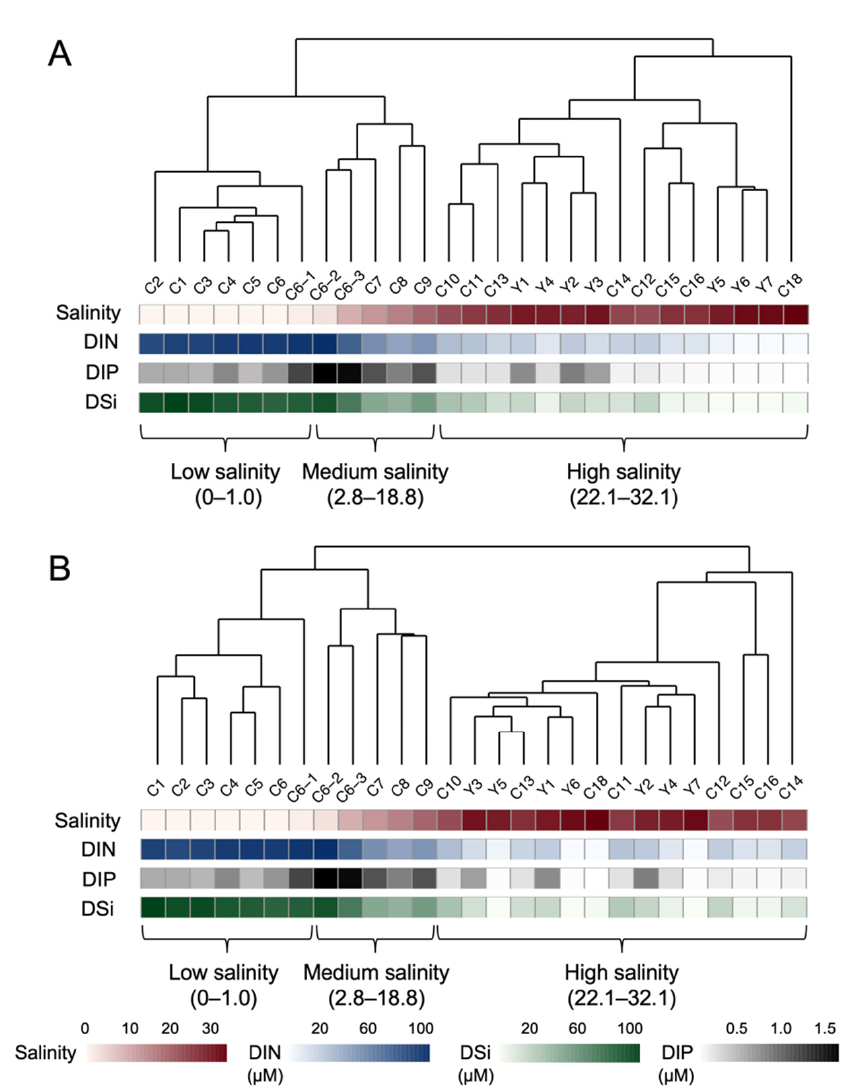
Figure 2. UPGMA clustering based on bacterial ( A ) and protistan ( B ) plankton community composition similarities. Samples were collected from surface water along two west–east transects of the Changjiang Estuary and its adjacent area with pronounced salinity gradient. Both bacterial and protistan plankton communities were clustered into three salinities: low-salinity cluster (0–1.0), medium-salinity cluster (2.8–18.8) and high-salinity cluster (22.1–32.1). Color stripes represent the values of four environmental parameters at each station.